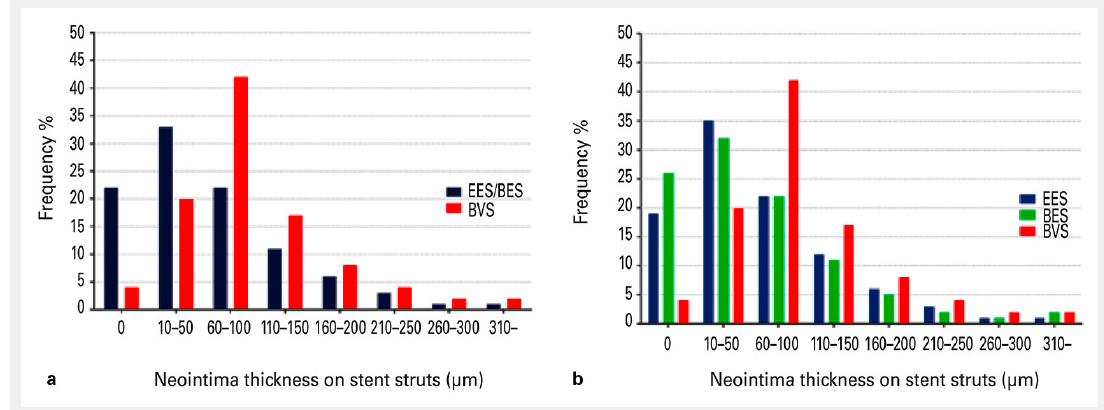
Figure 3a and b Frequency distribution of mean neointima thickness at intervals of 50 µm. BES = biolimus-eluting stent; BVS = bioresorbable vascular scaffold; EES = everolimus-eluting